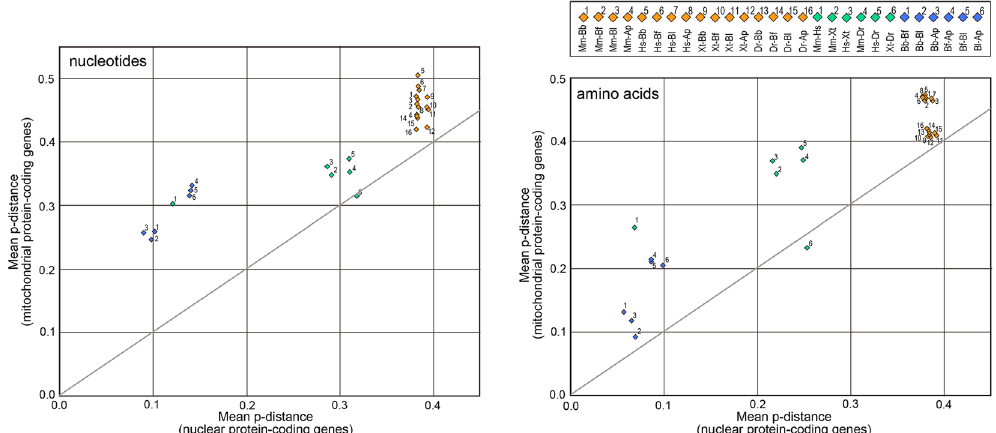
Figure 2. p-distances of mitochondrial and nuclear protein-coding genes between amphioxus and vertebrate taxa. Pairwise p-distances of nucleotide and amino acid sequences of 13 mitochondrial and 952 nuclear genes were calculated for all combinations of four amphioxus and four vertebrate species. The pairwise distances were calculated using MEGA-CC 71 and plotted by mean values for all corresponding species